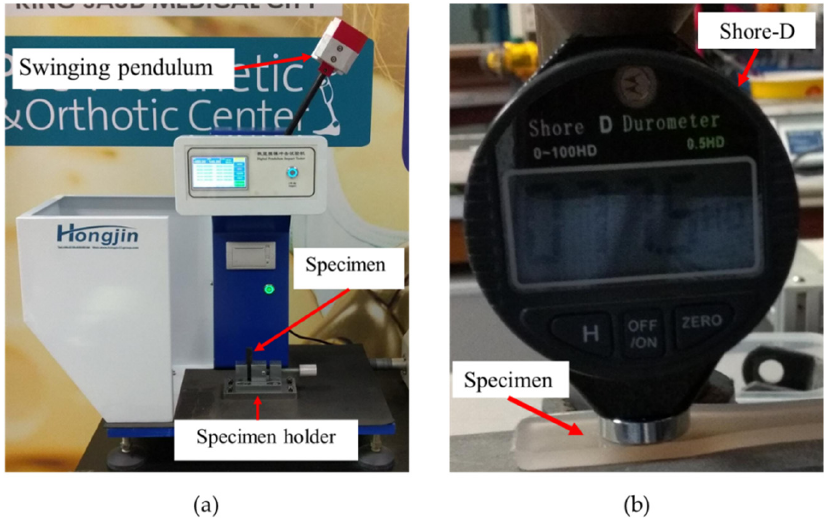
Figure 5. ( a ) Izod impact and ( b ) hardness shore-D testing.